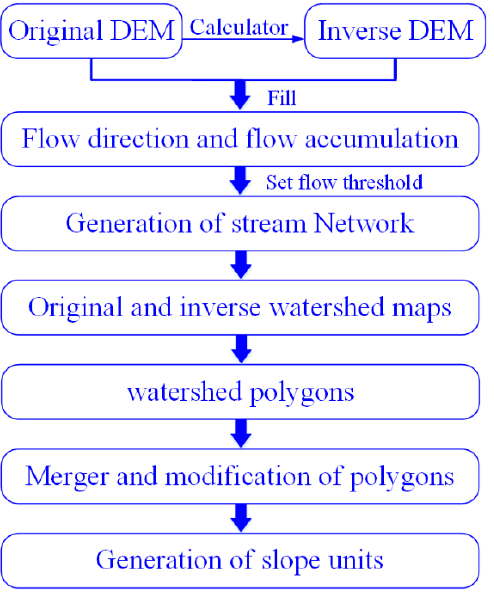
Figure 2. Schematic of slope unit extraction using the hydrological method.